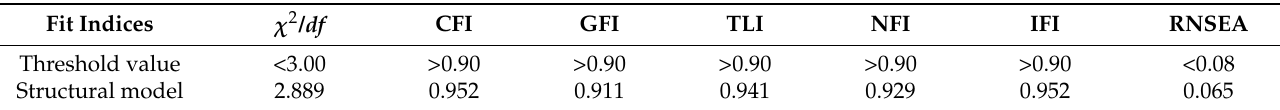
Table 4. Structural model fitting